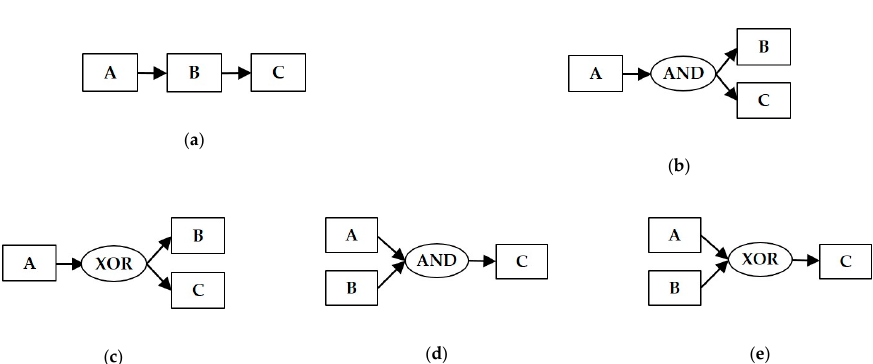
Figure 7. Workflow modeling patterns: ( a ) sequential operation, ( b ) parallel operation (AND-split),